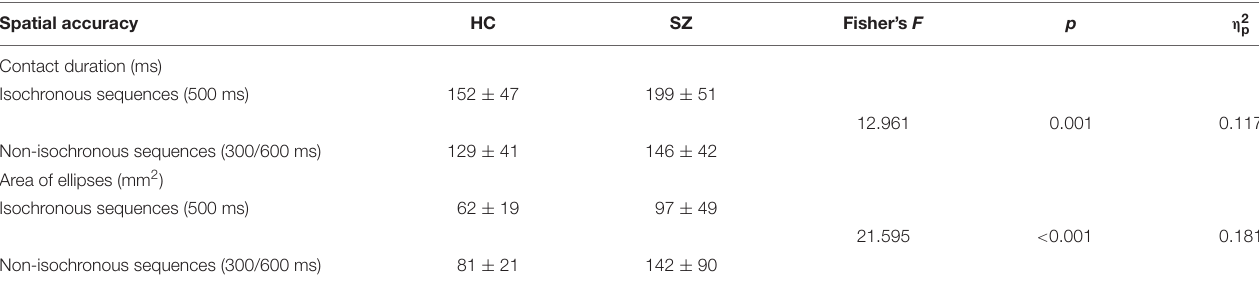
TABLE 2 | Summary of findings obtained for the spatial accuracy and contact durations (CD in ms) in the patient and in the control groups as a function of the different rhythmic complexity conditions. Spatial accuracy